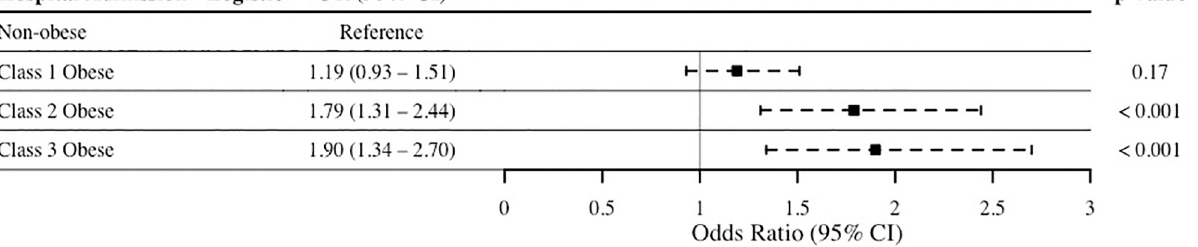
PLOS ONE | https://doi.org/10.1371/journal.pone.0272331 August 11,